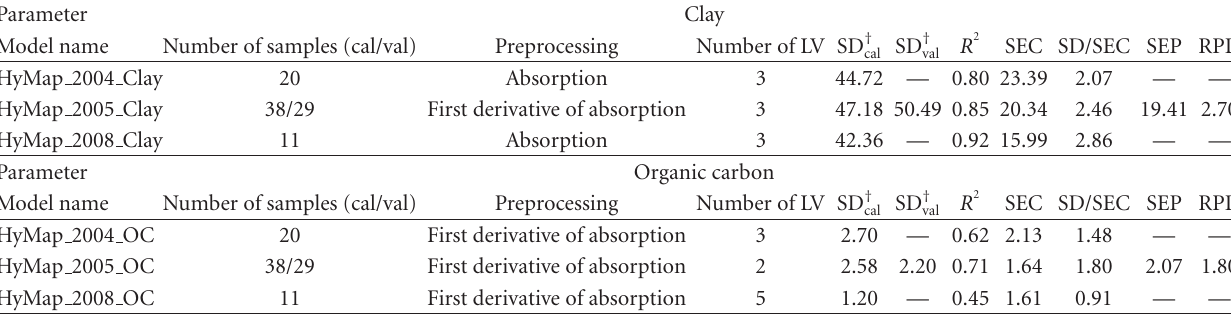
Table 7: Calibration and validation performance statistics of HyMap image